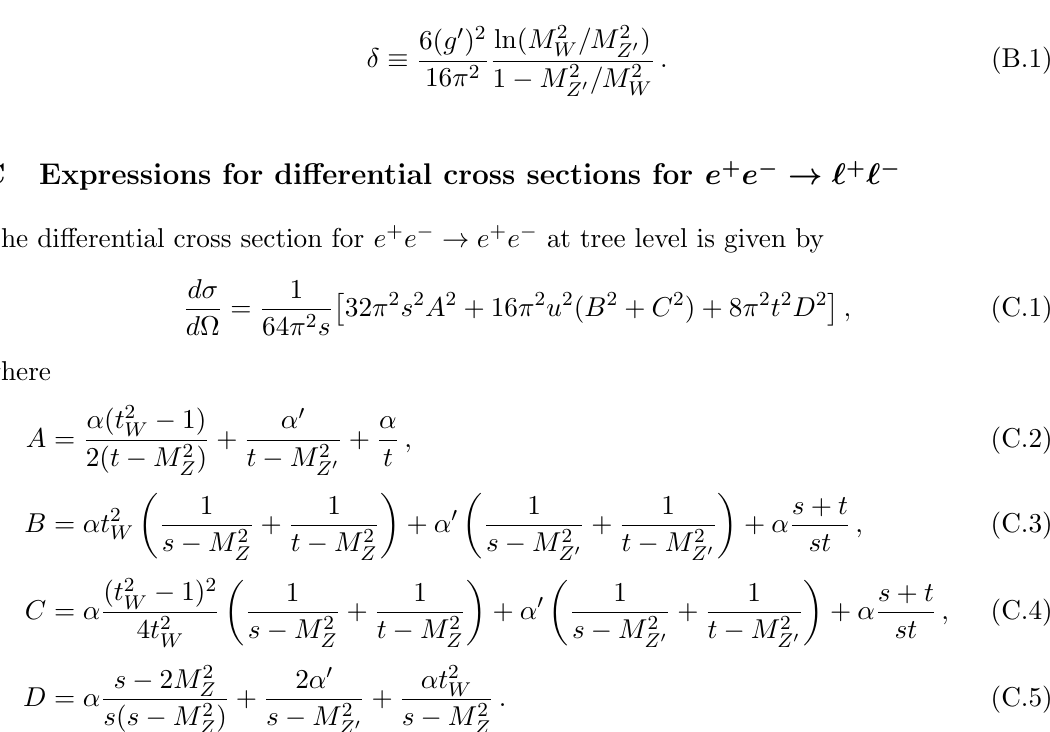
Table 3 . Expressions for (cid:14)